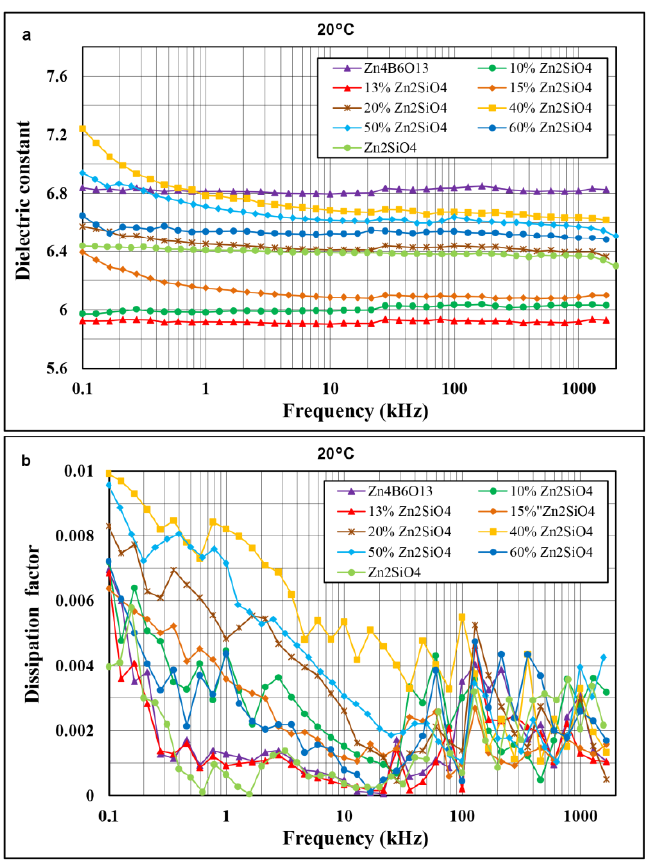
Figure 7. Comparison of frequency dependences of dielectric constant ( a ) and dissipation factor ( b ) at 20 °C in the range of 100 Hz-2 MHz for Zn 4 B 6 O 13 , Zn 2 SiO 4 , and Zn 4 B6O 13 –Zn 2 SiO 4 composites.